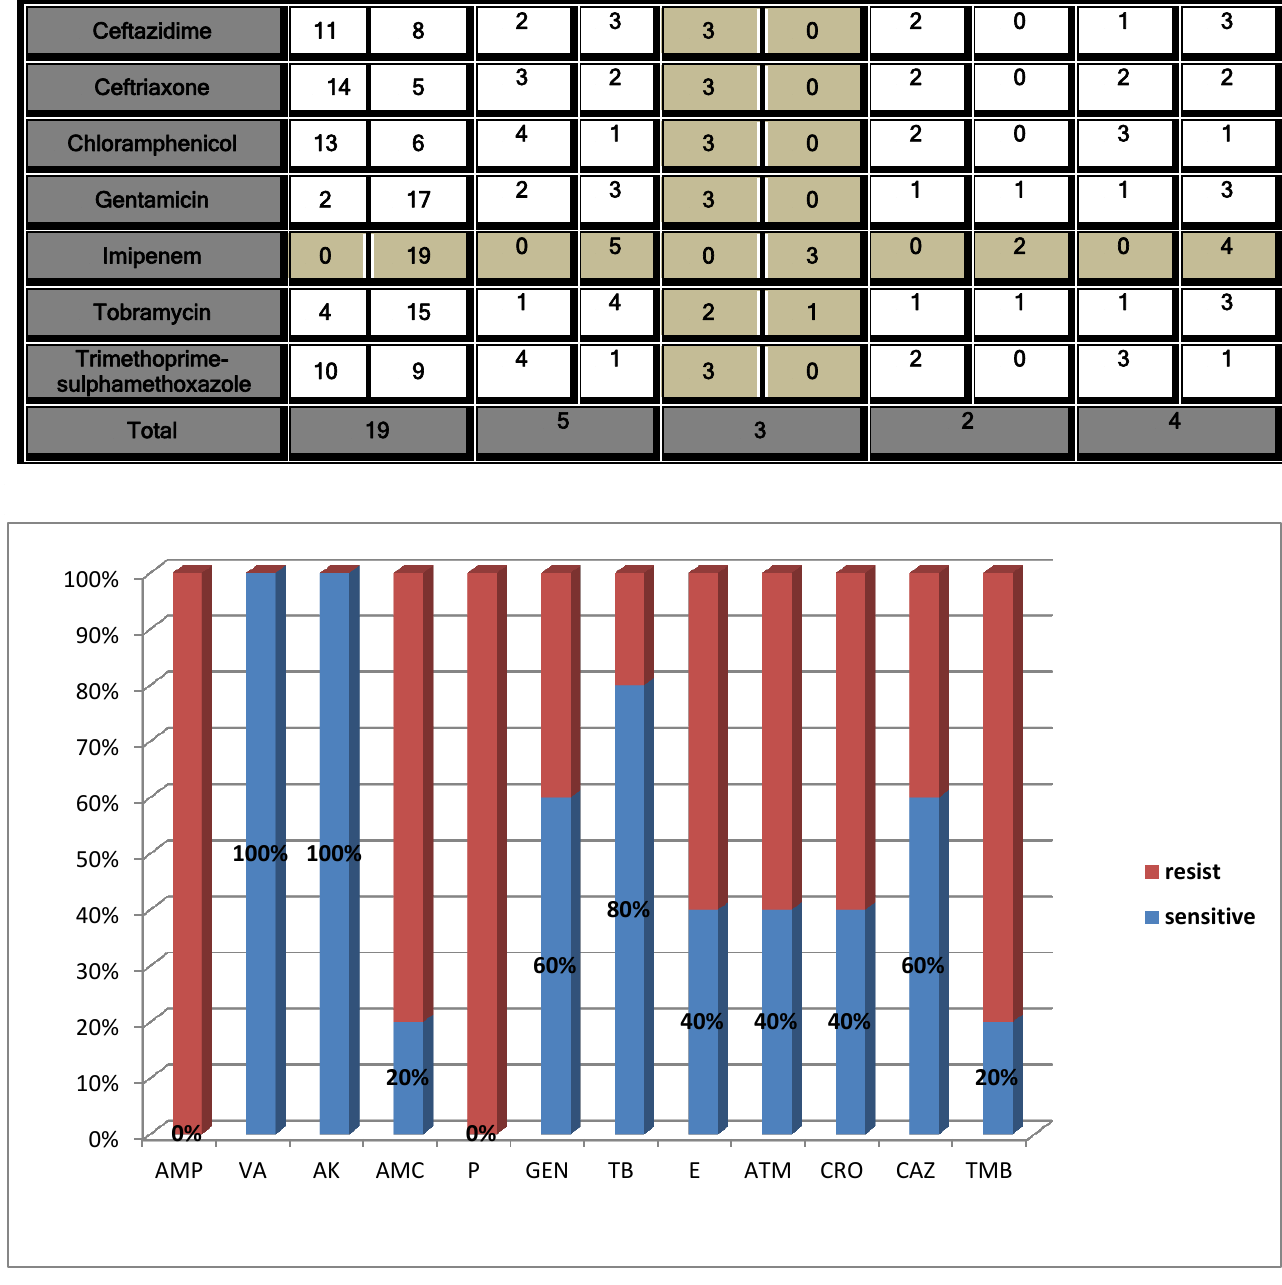
Figure -4: Antibiotic resistance of 5 Staphylococcus aureus isolates from urine cultures